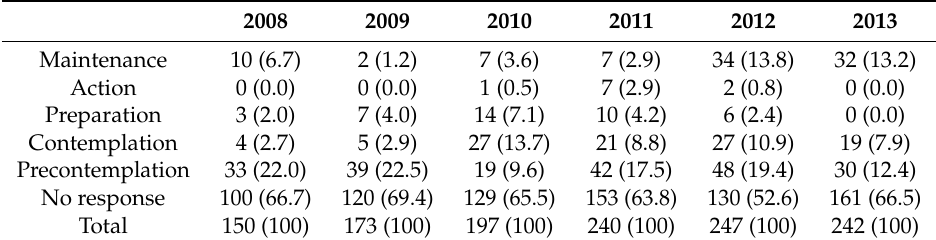
Table 2. Annual categorization of restaurants based on the survey responses.